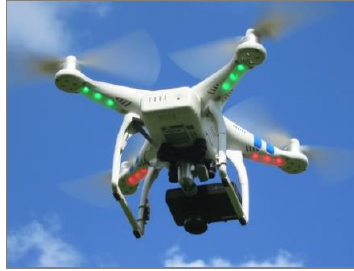
Figure 2. DJI ® Phantom 2 equipped with Canon Powershot 110 (Photo G. Bareth, 2014).